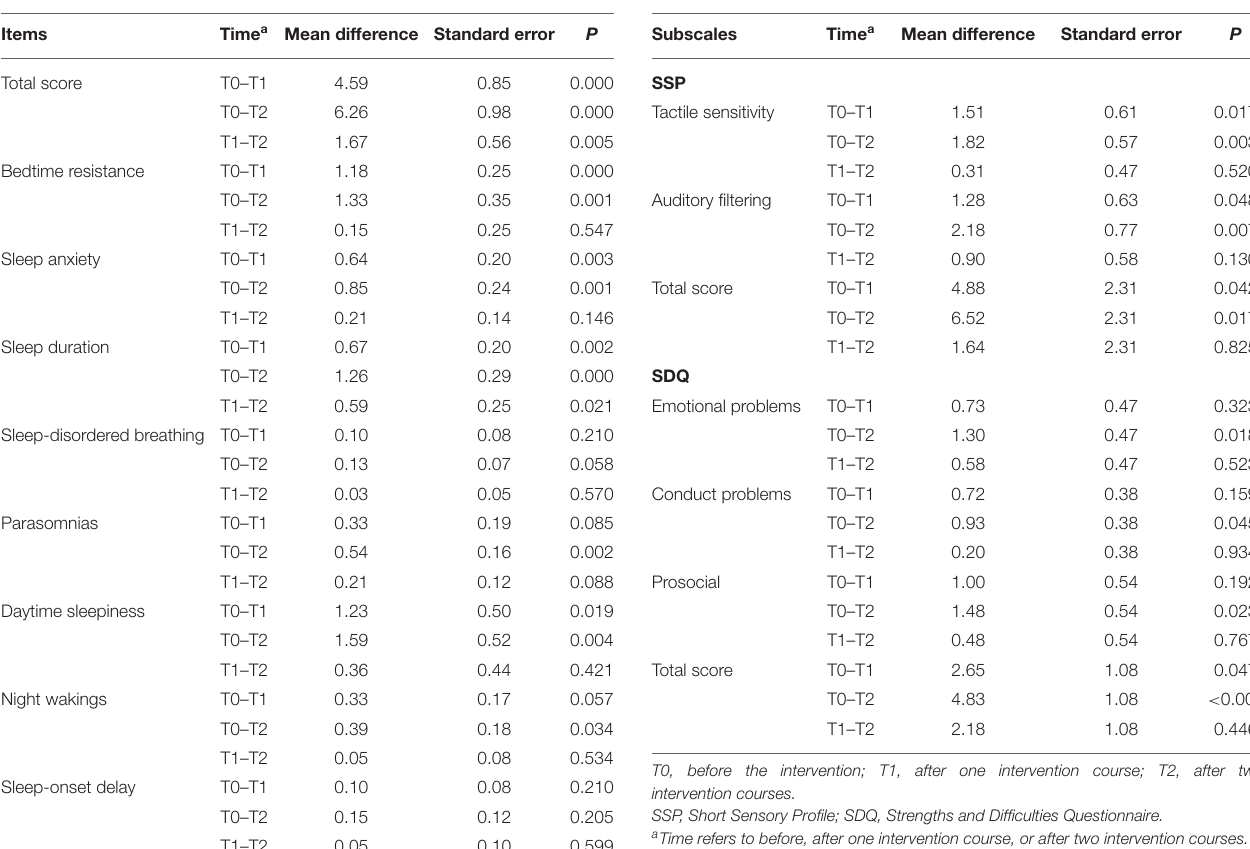
TABLE 3 | Comparison of SSP and SDQ before and after intervention in children with autism spectrum disorder ( n =